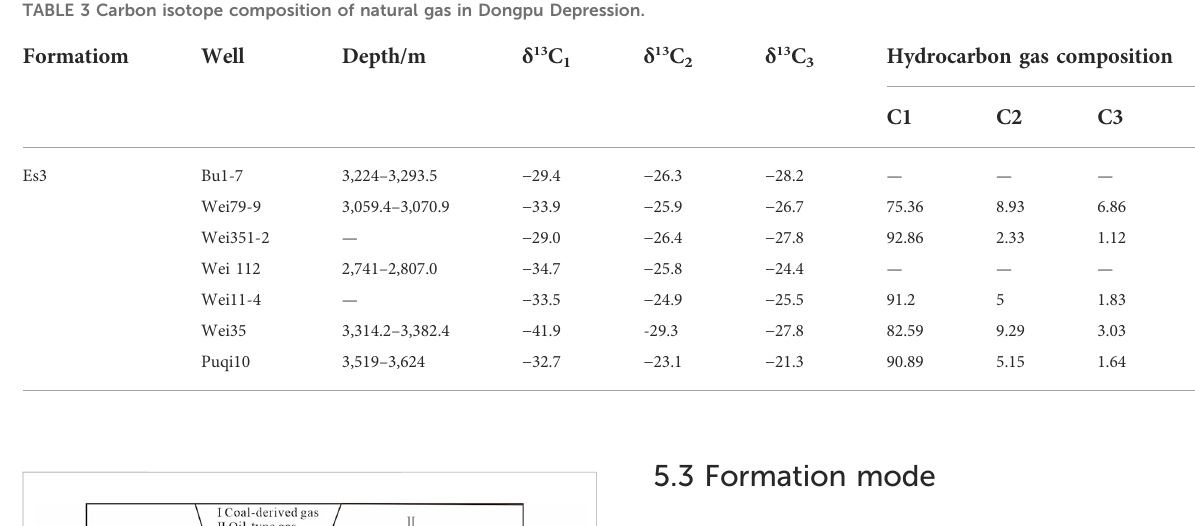
TABLE 3 Carbon isotope composition of natural gas in Dongpu Depression.